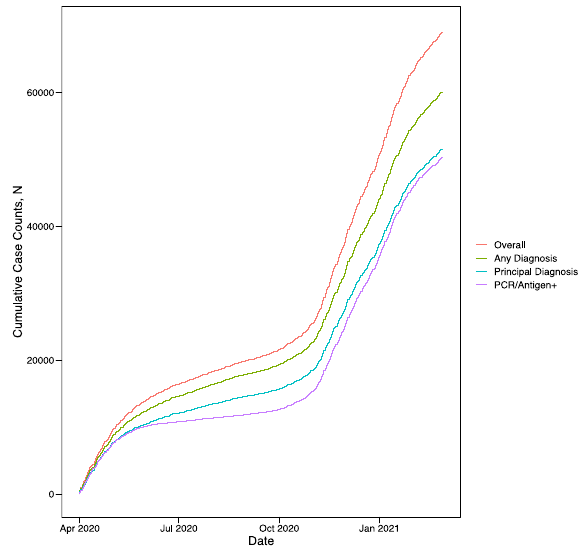
Fig. 1 SARS-CoV2 case counts by phenotyping strategy. The absolute cumulative SARS-CoV-2 cases by adjudication strategy across the study period. The cases are based on either principal diagnosis or any diagnosis, compared with a polymerase chain reaction or antigen test for